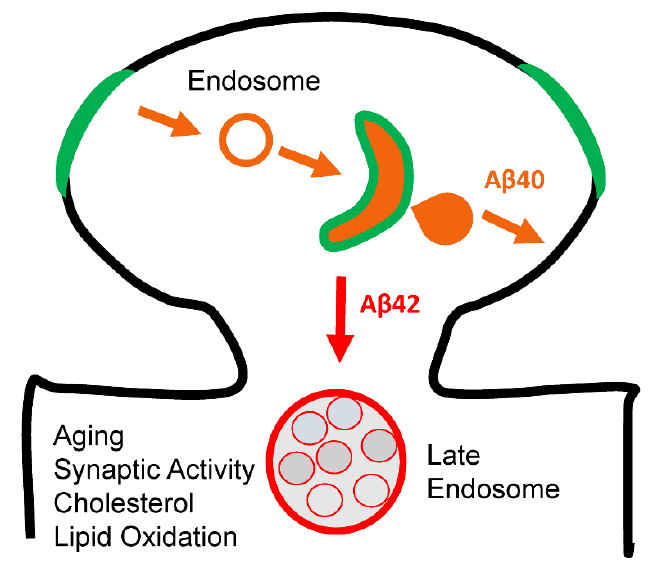
Figure 5. Model of Aβ biogenesis in the postsynaptic spines. Green membranes support active GD motion, orange membranes support active OD motion, orange areas favor accumulation of soluble Aβ40 and red membranes favor accumulation of Aβ42.